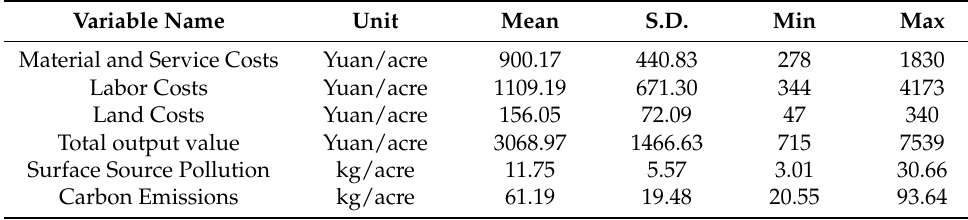
Table 1. Calculation index of citrus